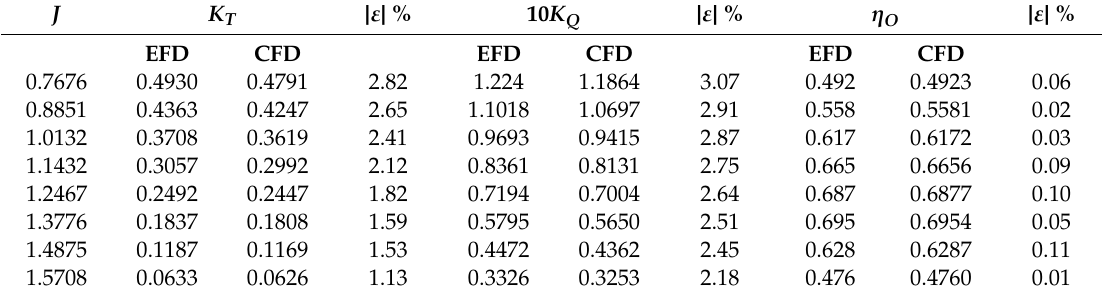
Figure 16. Grid convergence test for the propeller working in cavitation tunnel. Computational error versus the cubic root of the cell numbers ( N C ). ( a ): K T ; ( b ): 10 K Q . Table 9. Comparison between the open water performance coefficients measured and computed for the propeller working in the cavitation tunnel.